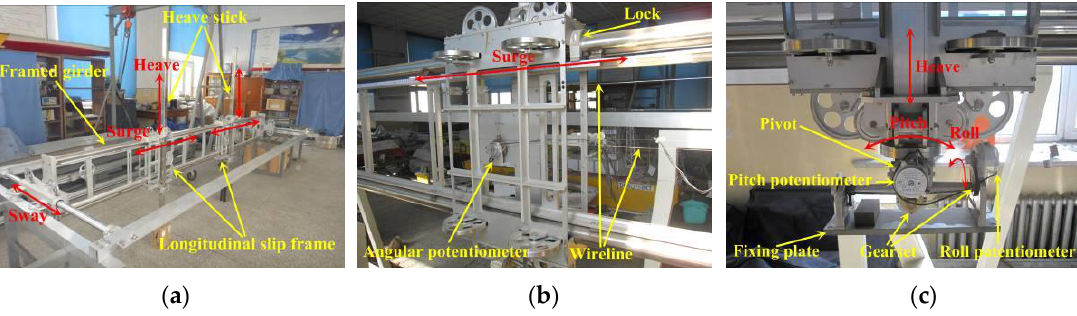
Figure 8. View of the 5-DOF seaworthiness instrument: ( a ) overview of the device; ( b ) longitudinal slip frame; ( c ) heave stick and angular pivot. slip frame; ( c ) heave stick and angular